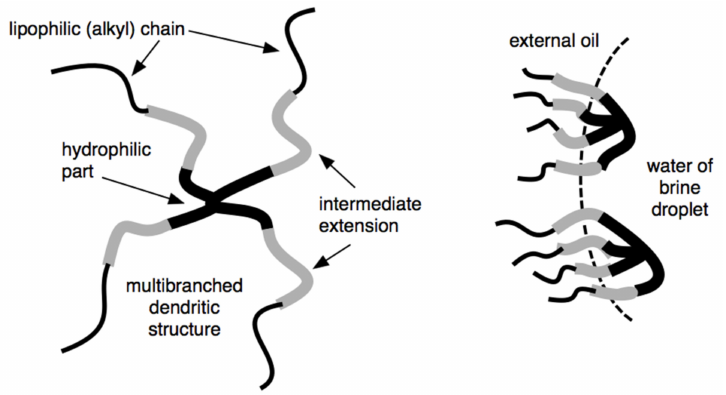
Figure 8. Dendritic extended surfactant ( left ) and its adsorption on a water drop interface in a drilling fluid W/O emulsion ( right ).